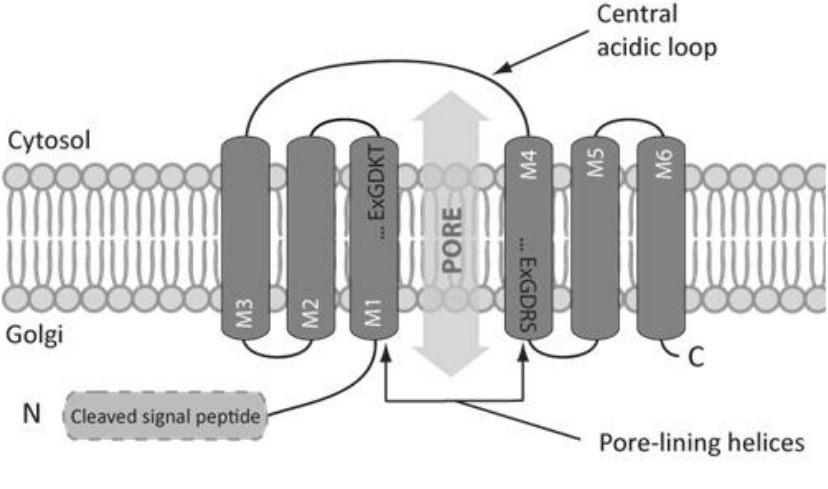
FIGURE 1: Predicted topology of the eukaryotic UPF0016 members. The eukaryotic UPF0016 members are pre- dicted to consist of two clusters of three transmembrane spans assembled in an antiparallel orientation and separated by a central loop enriched in negatively charged residues found at the cytosolic side in yeast, human, and bacteria. The featured UPF0016 motif Glu- φ -Gly-Asp- (Arg/Lys)-(Ser/Thr) is found in two cop- ies, in the transmembrane spans one and four. Due to the hydrophilic nature of the residues found in this motif, and its localization in hydrophobic trans- membrane spans, their two copies were hypothesized to form the pore of the protein through which the transported ions would cross the membrane